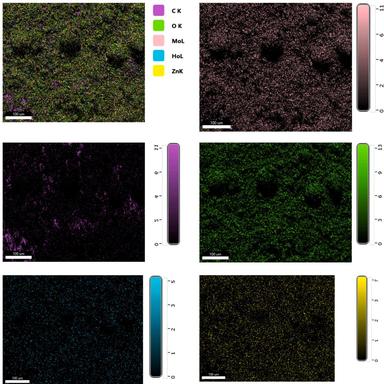
EDS mapping for MTZ - ZnMoO4 nanocomposite.